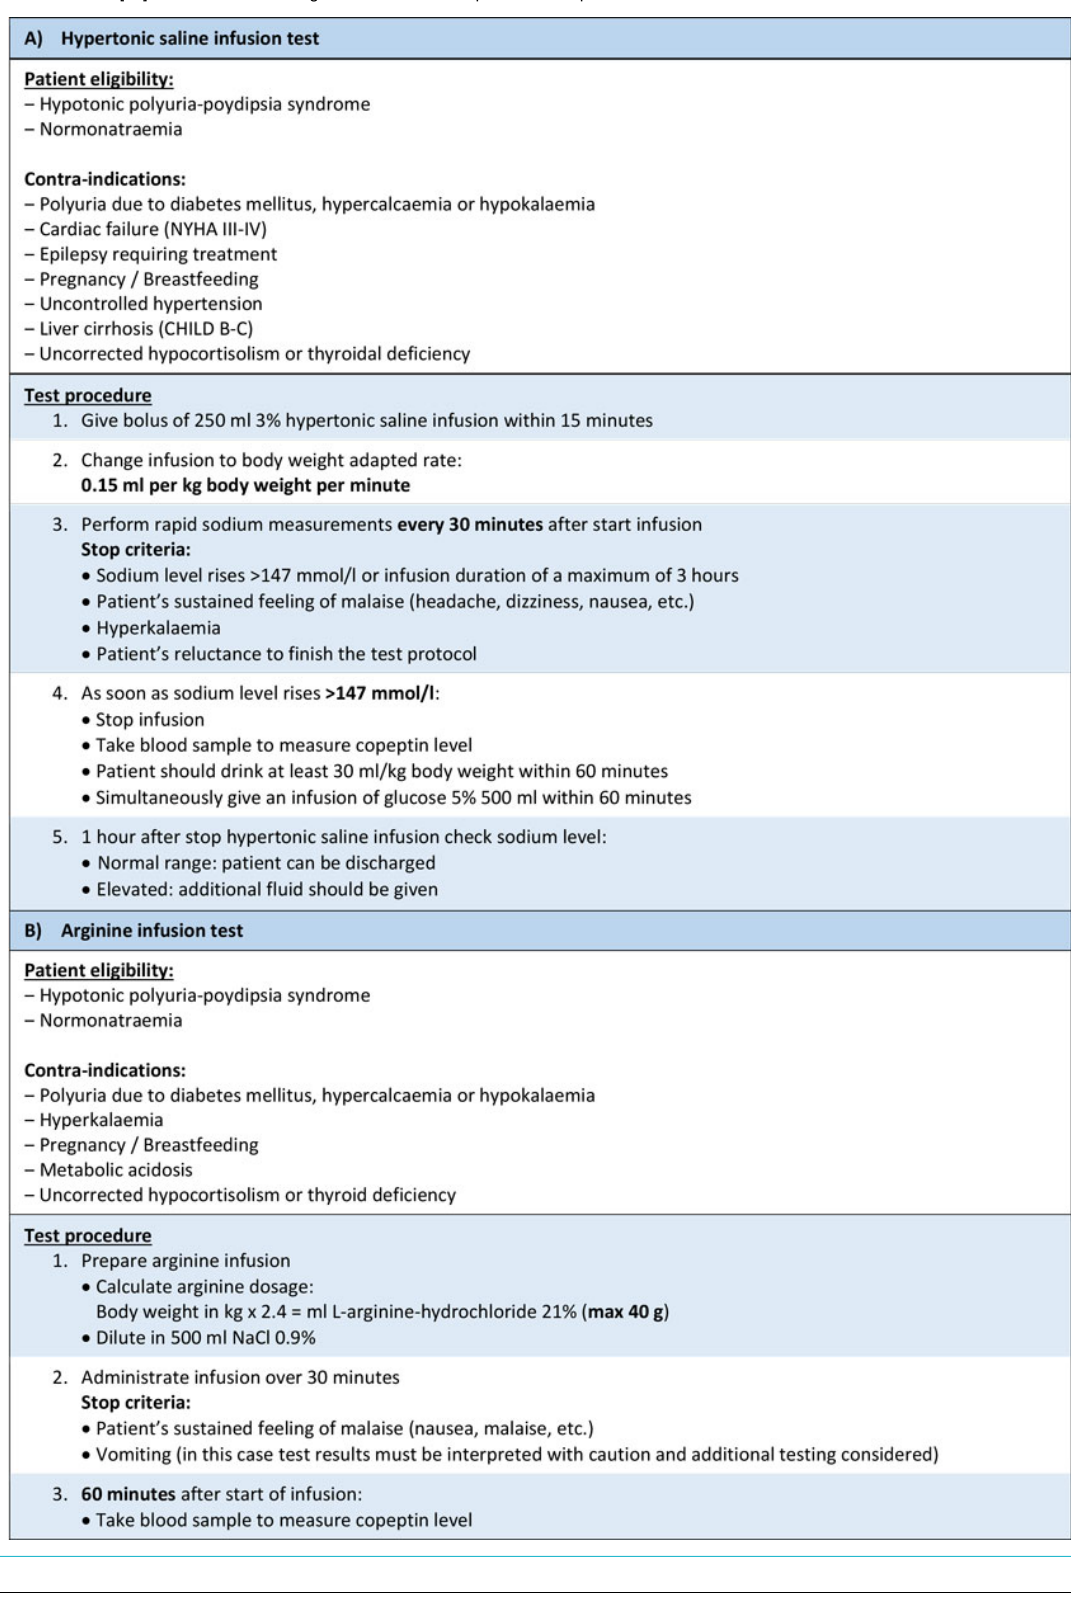
Figure 2: Test protocols for (A) the hypertonic saline infusion test according to Fenske et al [47] and (B) the arginine infusion test according to Winzeler et al. [61] for the differential diagnosis of diabetes insipidus in adult